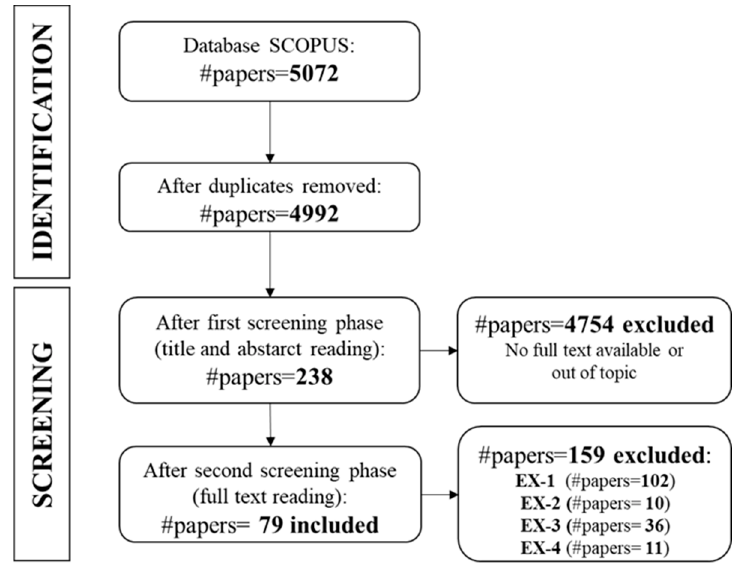
Figure 2. Systematic literature review process.